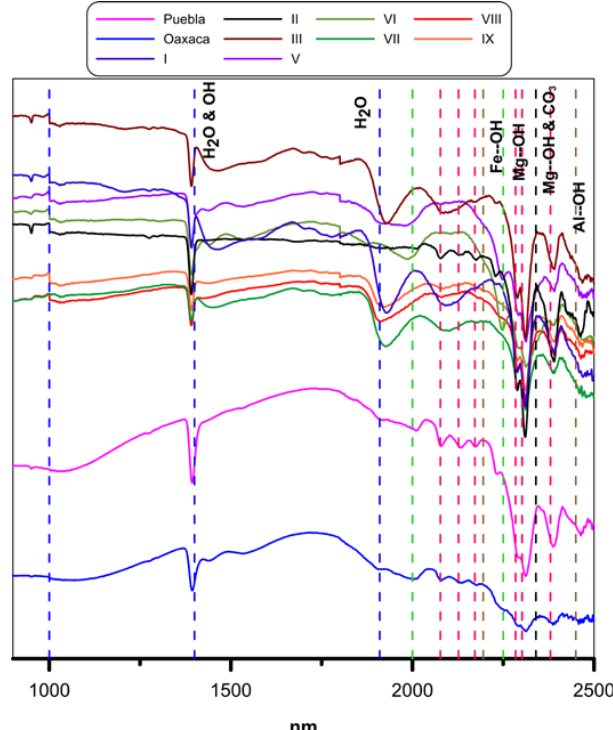
Figure 5. SWIR absorption bands for different types of talcs. In red, bands associated to talc; in green, bands associated with chlorite; in blue, bands associated to water and in brown, bands associated with Al-OH and probably with clay minerals.